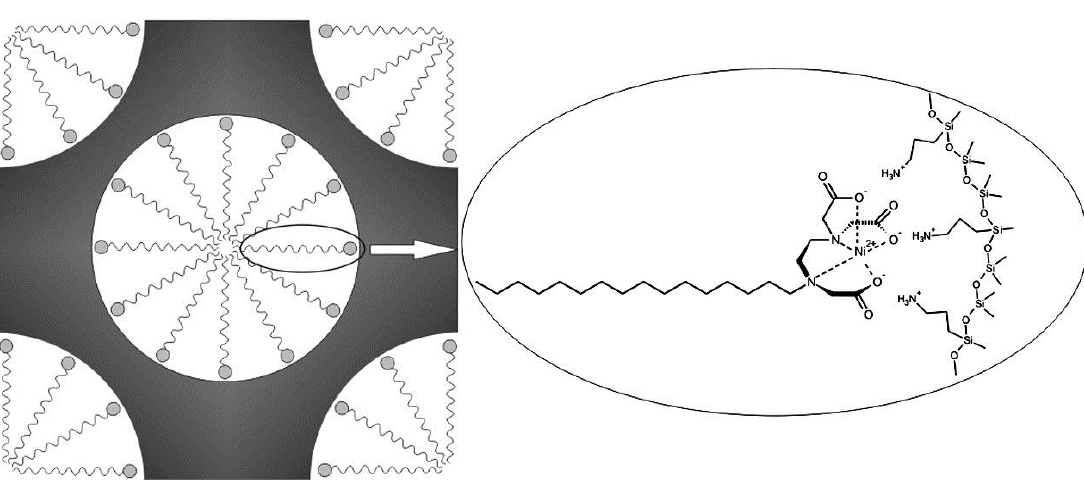
Figure 6. Schematic illustration of HED3A-assisted introduction of nickel (II) into mesopores. Reprinted from Ref. [53], Copyright 2011, with permission from Elsevier.